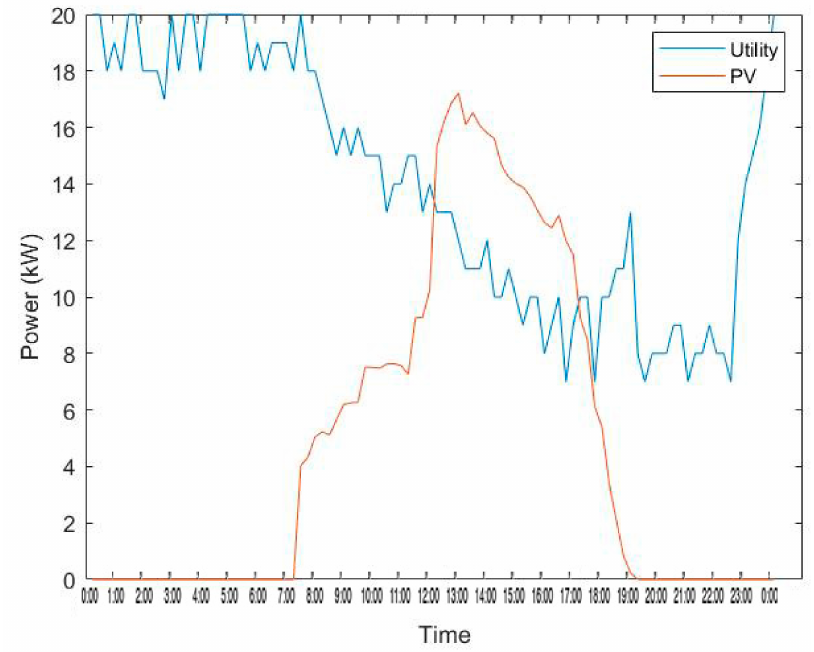
Figure 11. Utility grid power supply and PV